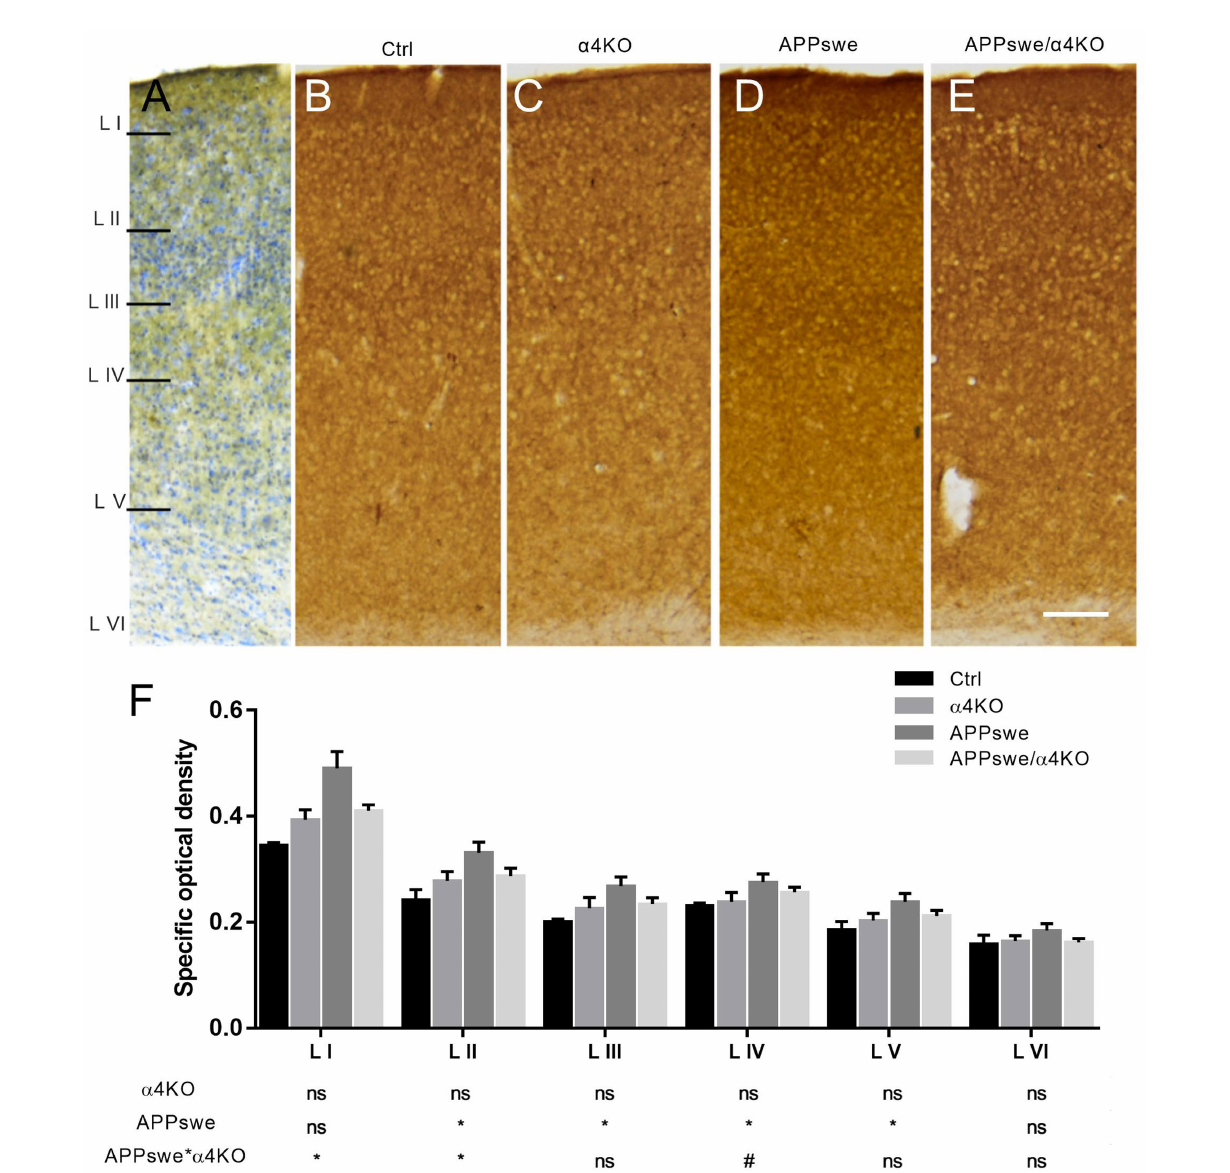
FIGURE 3 Quantitative analysis of SYN immunoreactivity in the somatosensory cortex of 15 mo mice. (A–E) Representative images of SYN ir in layers I-VI of sCtx (A) of 15 mo Ctrl (B) , α 4KO (C) , APPswe (D) , and APPswe/ α 4KO (E) mice. Scale bar: 200 μ m. (F) Densitometric analysis of SYN ir in layers I–VI of sCtx. Data are shown as mean ± SEM and compared by two-way ANOVA test, * p < 0.05, # 0.10 > p > 0.05 as trend for a significant difference. L I–VI, layers